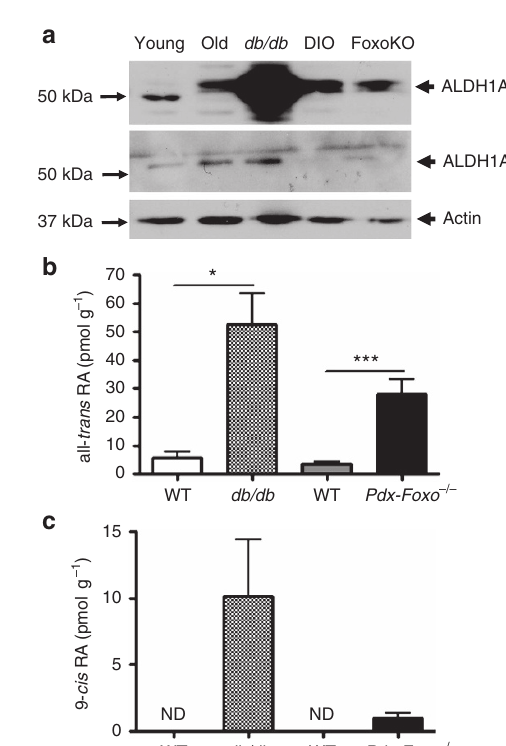
Figure 1 | Increased levels and activity of ALDH1A3 in diabetic mice. ( a ) Western blot of ALDH1A3 in islets isolated from different models of wild-type and diabetic mice. The lower molecular weight band in young (3-month-old) mice is a non-specific band commonly observed with Aldh1a3 immunodetection. ( b , c ) All- trans ( b ) and 9- cis retinoic acid ( c ) in whole pancreas of control and diabetic mice. Shaded bars: db/db mice and their wild-type controls. Filled bars: Pdx-cre Foxo knockout mice and their wild-type controls ( n ¼ 5 for each group). One asterisk indicates P o 0.05 by one-way ANOVA. Error bars indicate